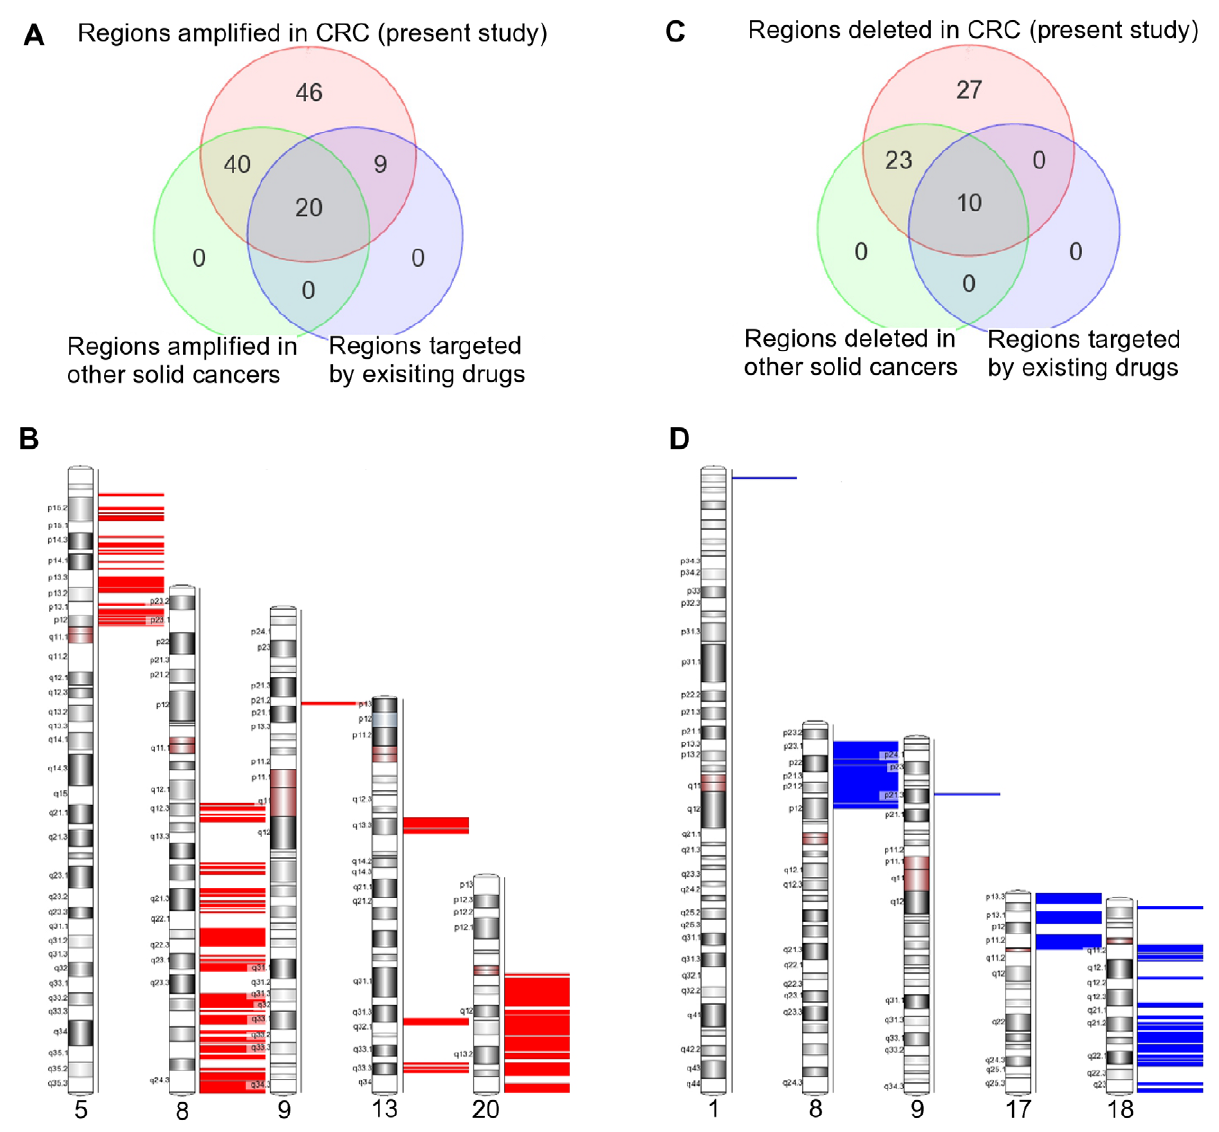
Figure 13. Common regions of amplification/deletion in this study and previous studies of other solid cancers. (a) Regions of amplification in our study (red circle) were also found in previous studies of other solid cancers (green circle); several are also known to be down- regulated by drugs that are approved or in development (blue circle). (b) Locations of the common regions of amplification in our study and previous studies of other solid cancers (intersection of red and green circles in Fig. 13a) are shown. (c) Regions of deletion in our study (red circle) were also found in previous studies of other solid cancers (green circle); several are also known to be up-regulated by drugs that are approved or in development (blue circle). (d) Locations of the common regions of deletion in our study and previous studies of other solid cancers (intersection of red and green circles in Fig. 13d) are shown. doi:10.1371/journal.pone.0031968.g013 PLoS ONE |